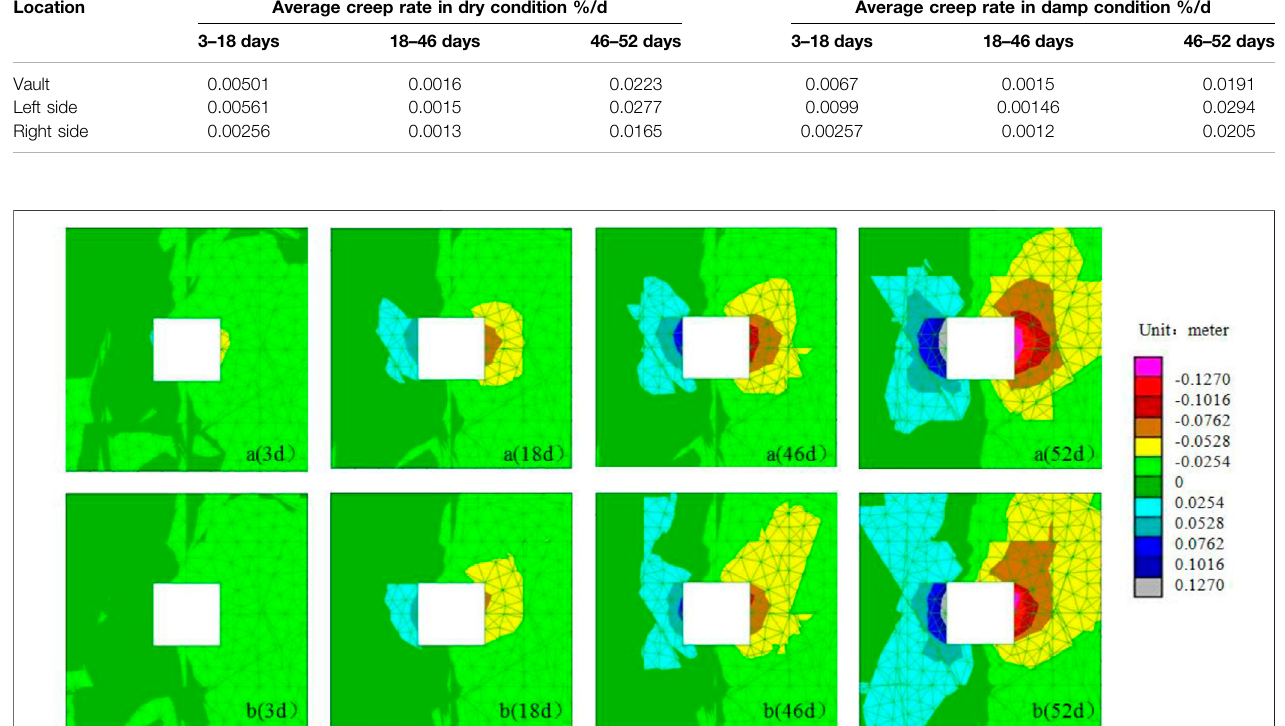
FIGURE 9 | Nephogram of horizontal displacement of roadway surrounding rock under different states (a dry state, b damp state).